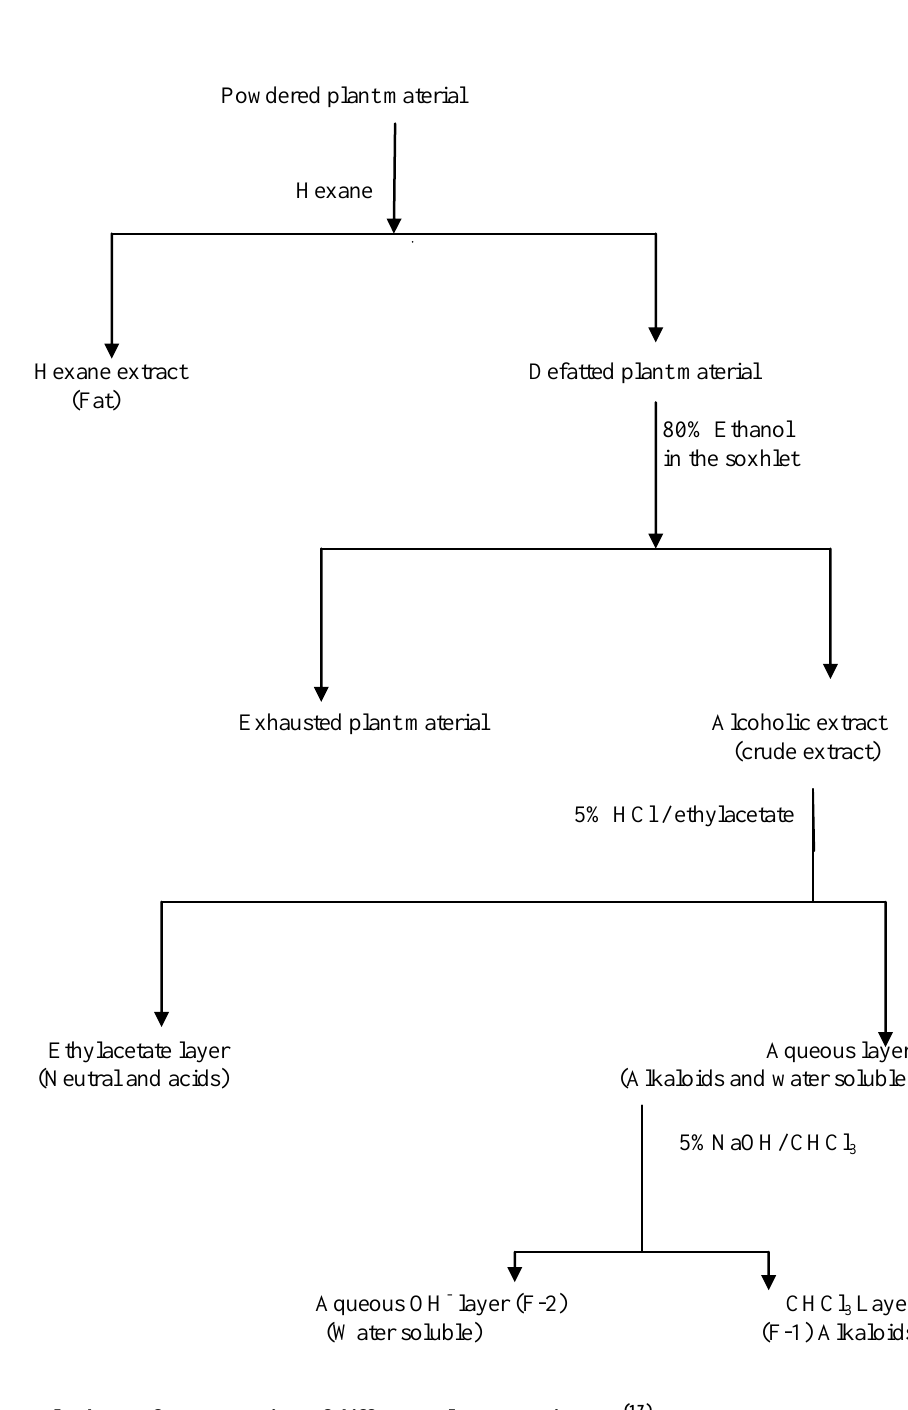
Figure:2 General scheme for separation of different plant constituents